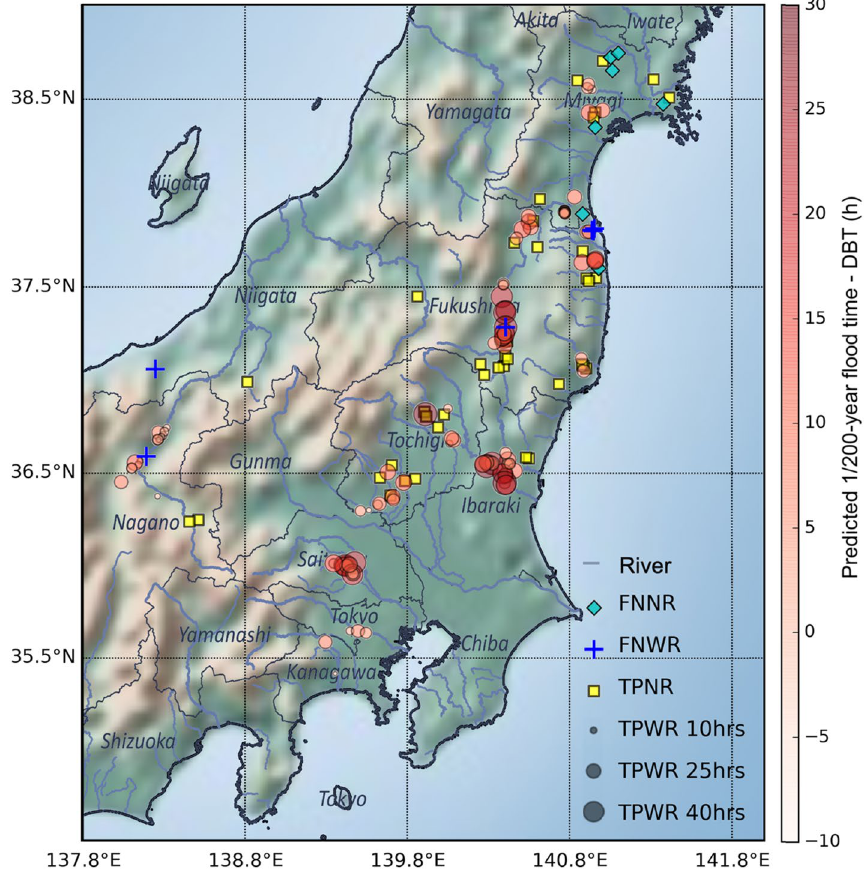
Figure 3. Forecasted locations and lead time distribution. FNNR indicates false-negative sites with no DBT records (blue diamonds, 8 spots). FNWR indicates false-negative locations with DBT records (blue crosses, 4 spots). TPWR (80 spots) and TPNR (50 spots) indicate locations that were successfully predicted (true positive) with and without DBT records, respectively. The color of the circle indicates how much the predicted 1/200-year flood time preceded the DBT at a given location. The size of the circle indicates the lead time in comparison with the predicted 1/200-year flood time. This figure was generated through Python2.7 (https:// www. python.